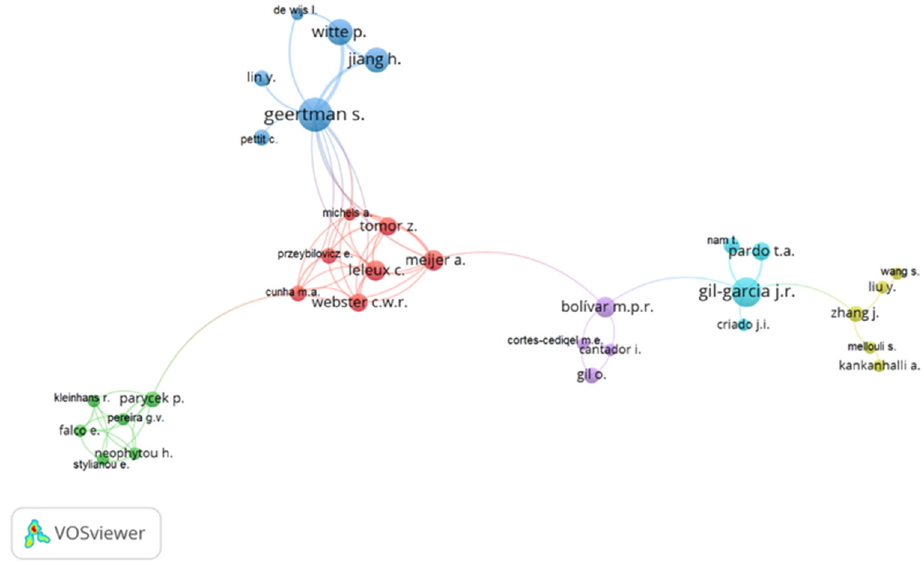
Figure 8. Co-authorship network showing authors’ collaboration on SPG research.